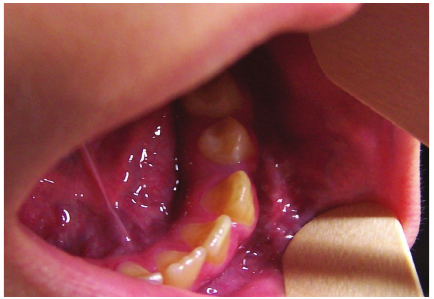
Figure 1: Initial intraoral picture.